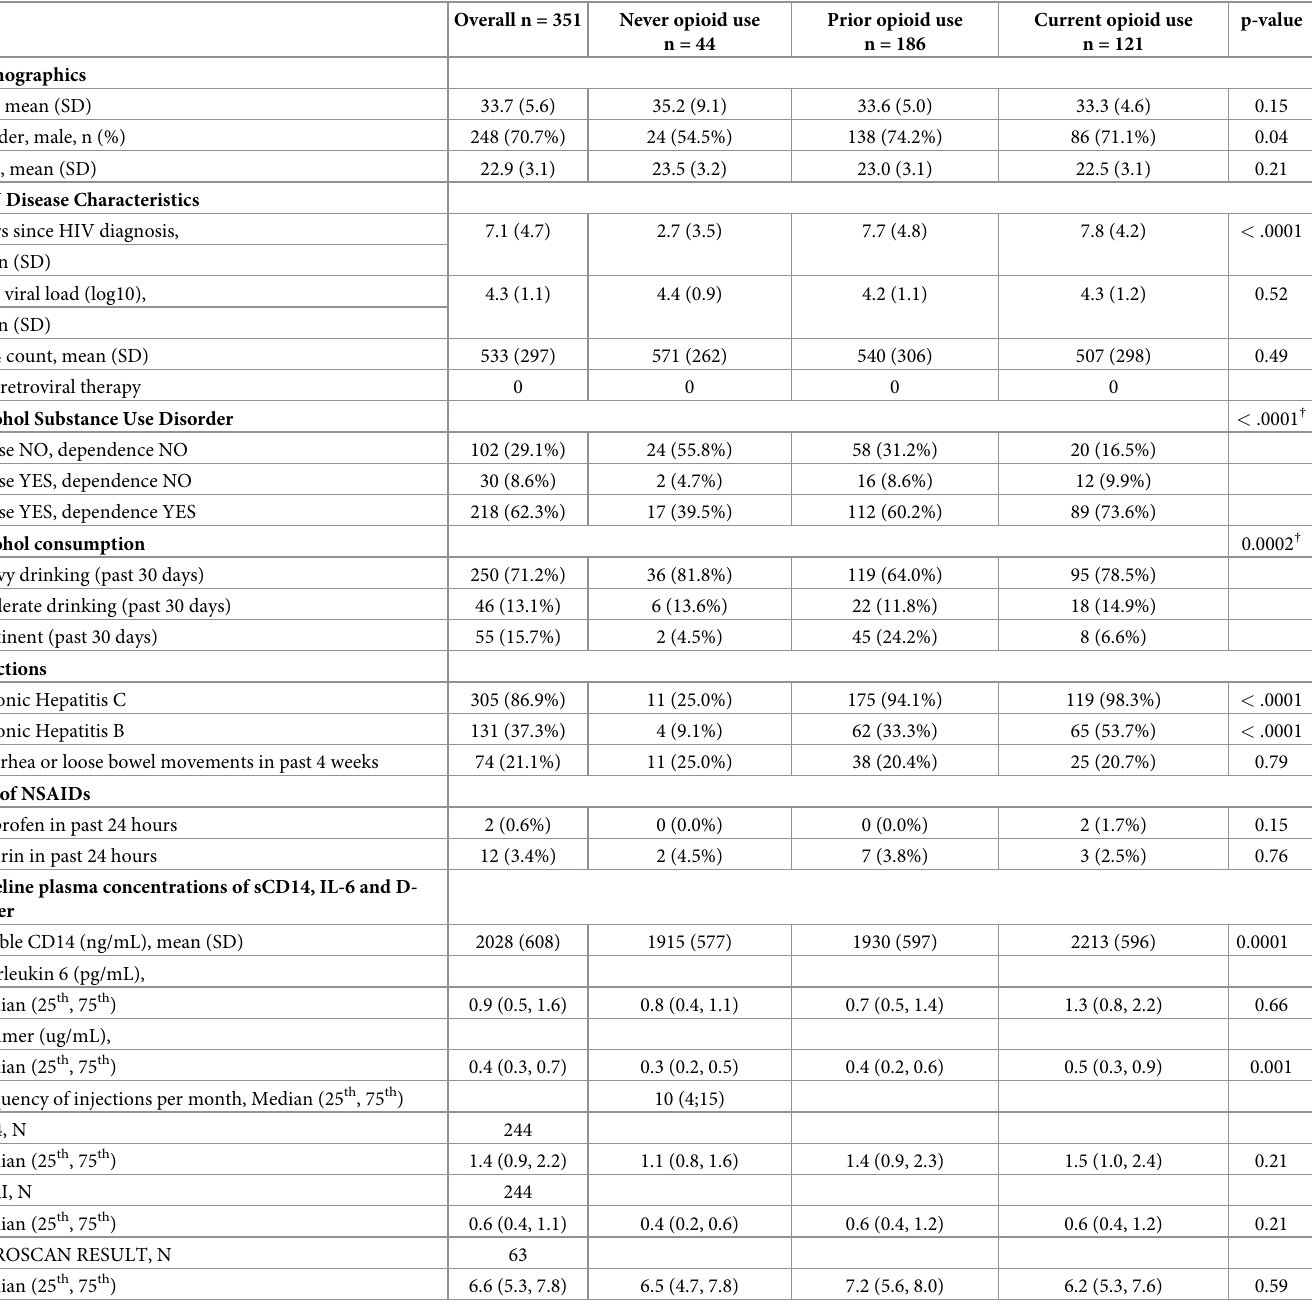
Table 1. Baseline demographic and clinical characteristics of Russian PLWH recruited